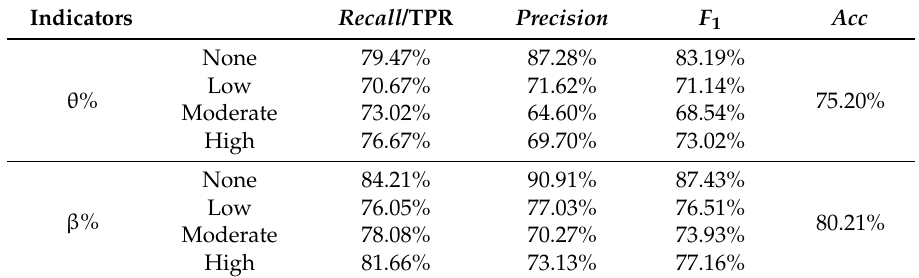
Table 6. The discrimination performances of the optimal thresholds (best cut-off points) of θ % and β %.